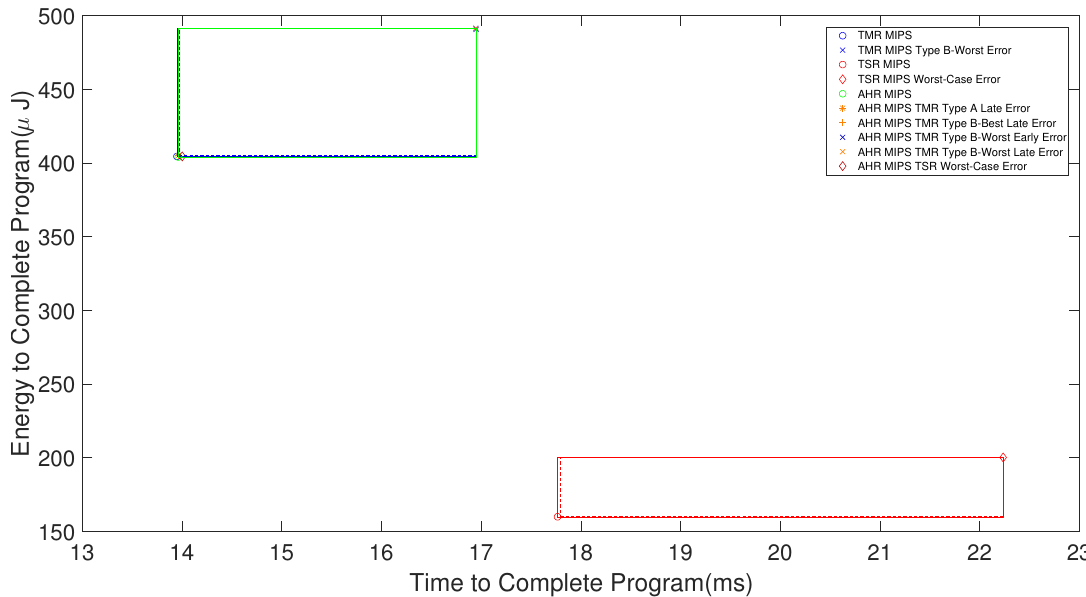
Figure 15. Average performance bounds for AHR MIPS with a TMR to TSR point at 80,000 instructions.